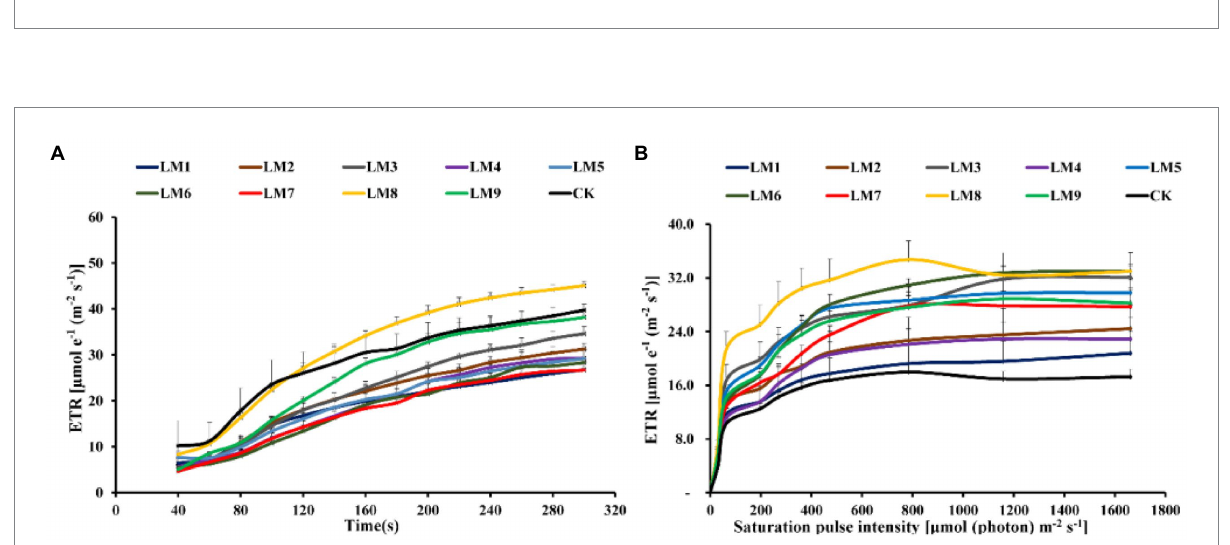
FIGURE 9 Effects of LED light modes on the induction kinetics of chlorophyll a fluorescence in dark-acclimated (A) and light-acclimated (B) of electron transport ratio (ETR) in strawberry leaves. The points represent the means ± SE of 16 ( × ) repeats, followed by the identical letters, indicating that the Duncan test found no significant differences ( p ≤